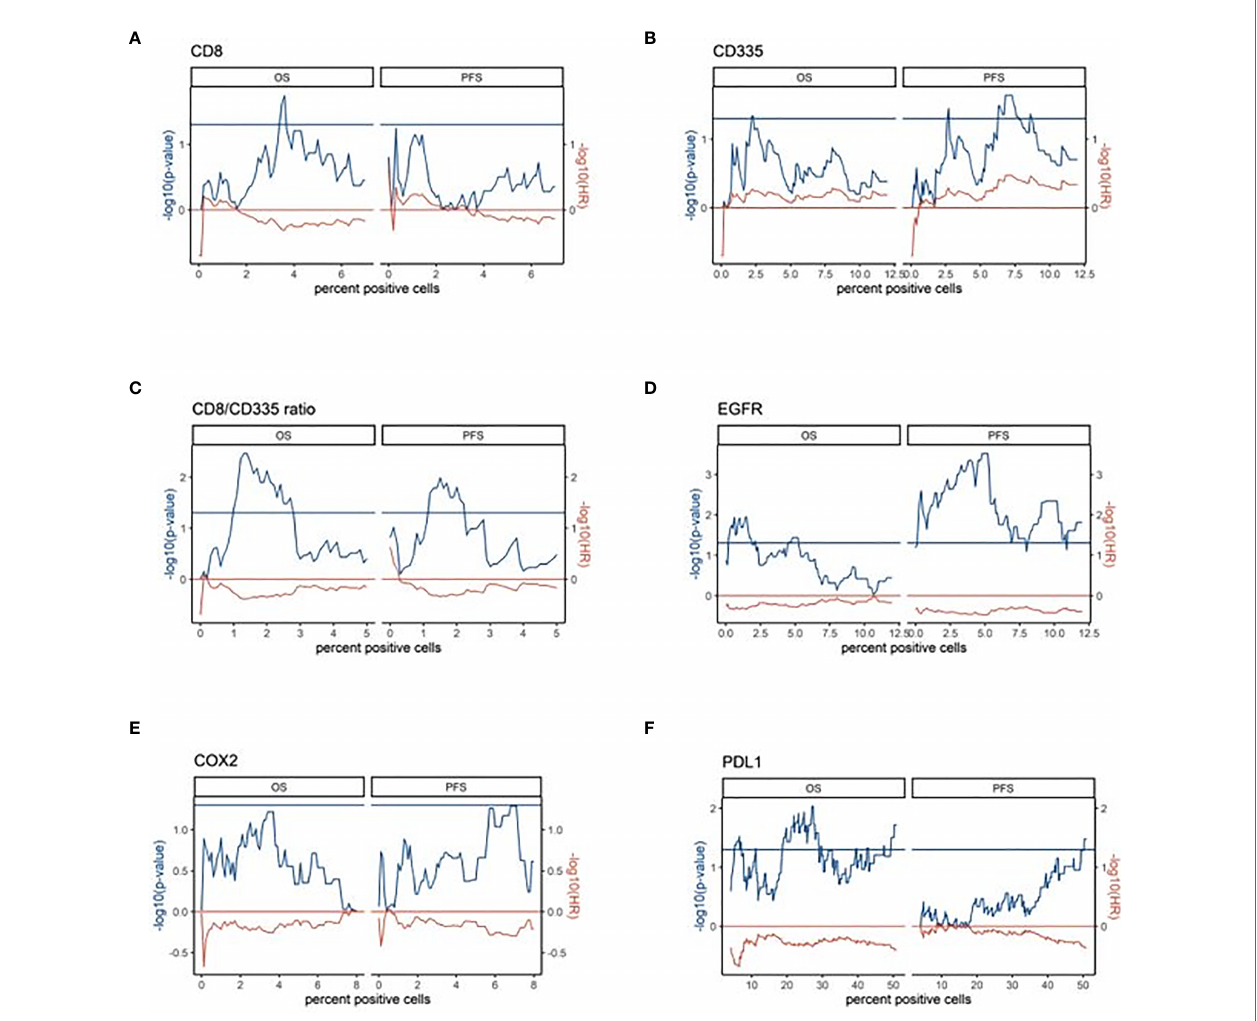
FIGURE 3 | Data-driven expression cut-offs of the digital scores for survival time analysis (A – F) . The p-values (cox proportional hazard model, -log10) and hazard ratios (-log10) of the univariate survival analysis are plotted over the percent of positive cells in the digital scoring. The left half of the respective plots show the results for OS and the right half for PFS. Horizontal lines illustrate the p-value cutoff (p < 0.05) and the direction of association (HR=1). Here, a negative – log10 HR corresponds to a shorter OS or PFS,